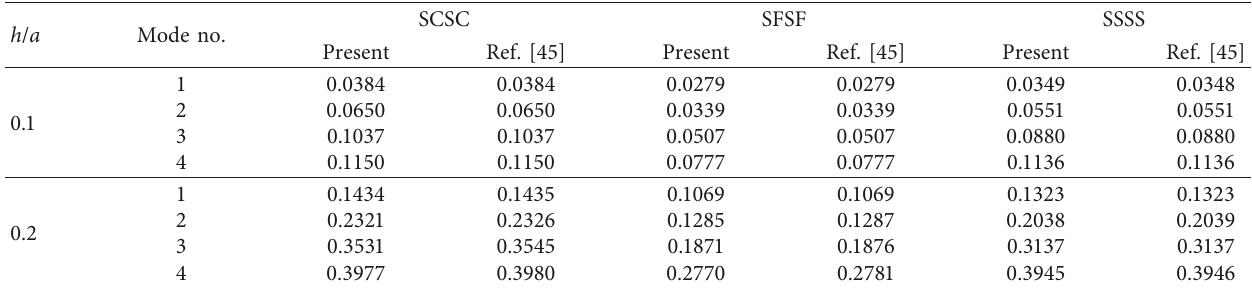
Table 4: Comparison of frequency parameters Ω of porous rectangular plates subjected to different boundary conditions. h /